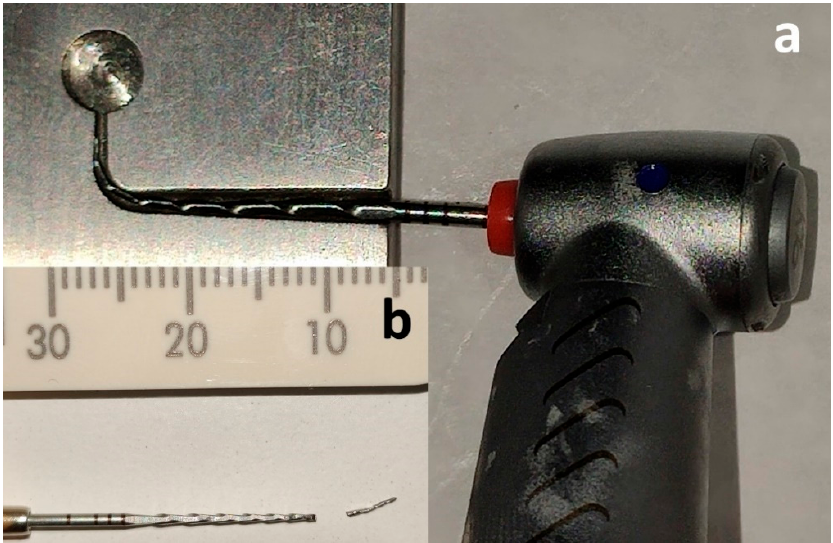
Figure 2. The instrument engaged in the artificial, stainless steel canal ( a ) and the fractured flat-sided instrument with its fragment ( b ).